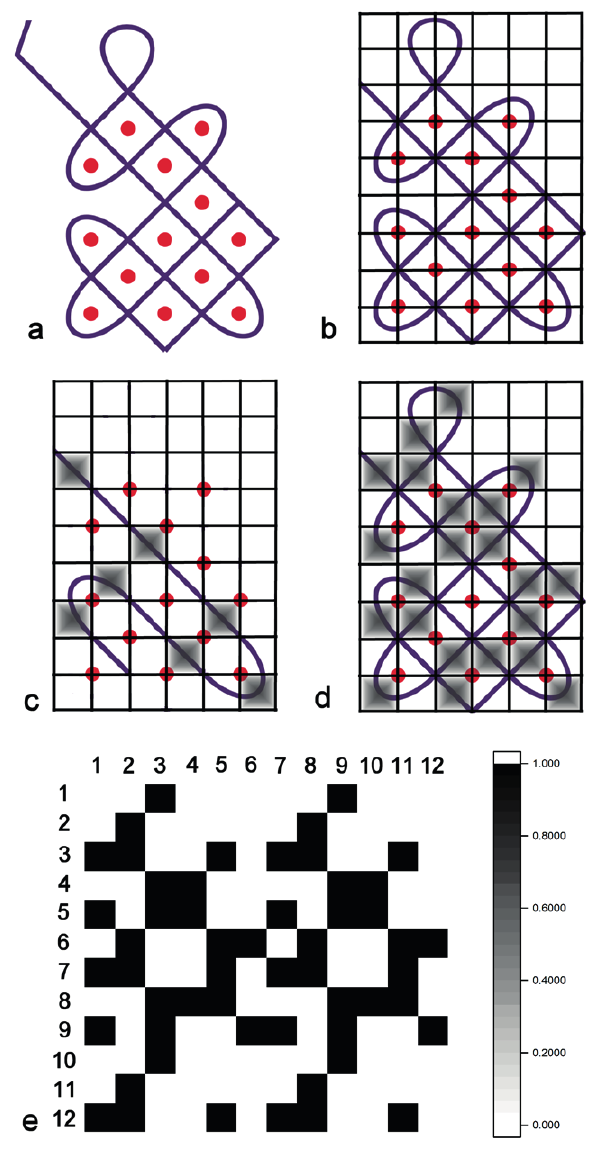
Figure 5. Steps involved in the conversion of a lusona drawing into a more intricate checkerboard pattern. The lusona in (a) represents a human. The same process as that applying to the pattern in Fig.4 is carried out (b-d) to create an extended pattern corresponding to the lusona drawing, with the dimensions comparable with the cell distance matrix (in this case 12 x 12 starting from a 6 x 9 sona)